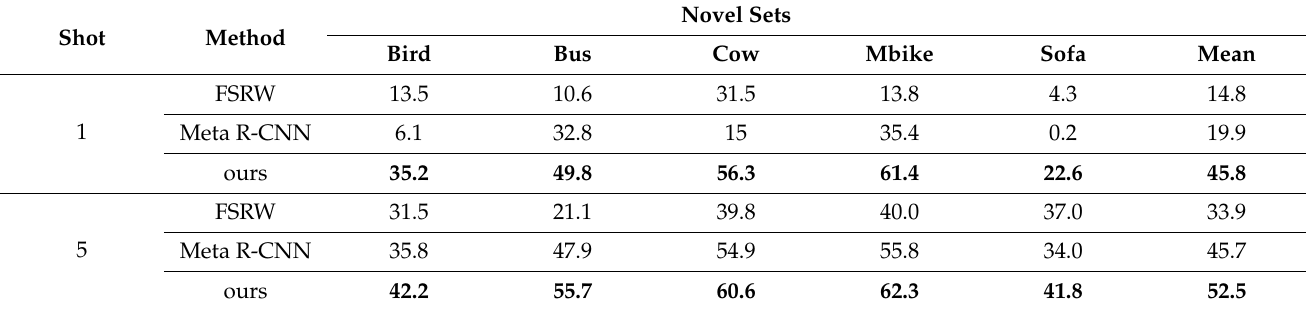
Table 4. Performance (AP50) of the novel classes in the VOC dataset compared with state-of-the- art